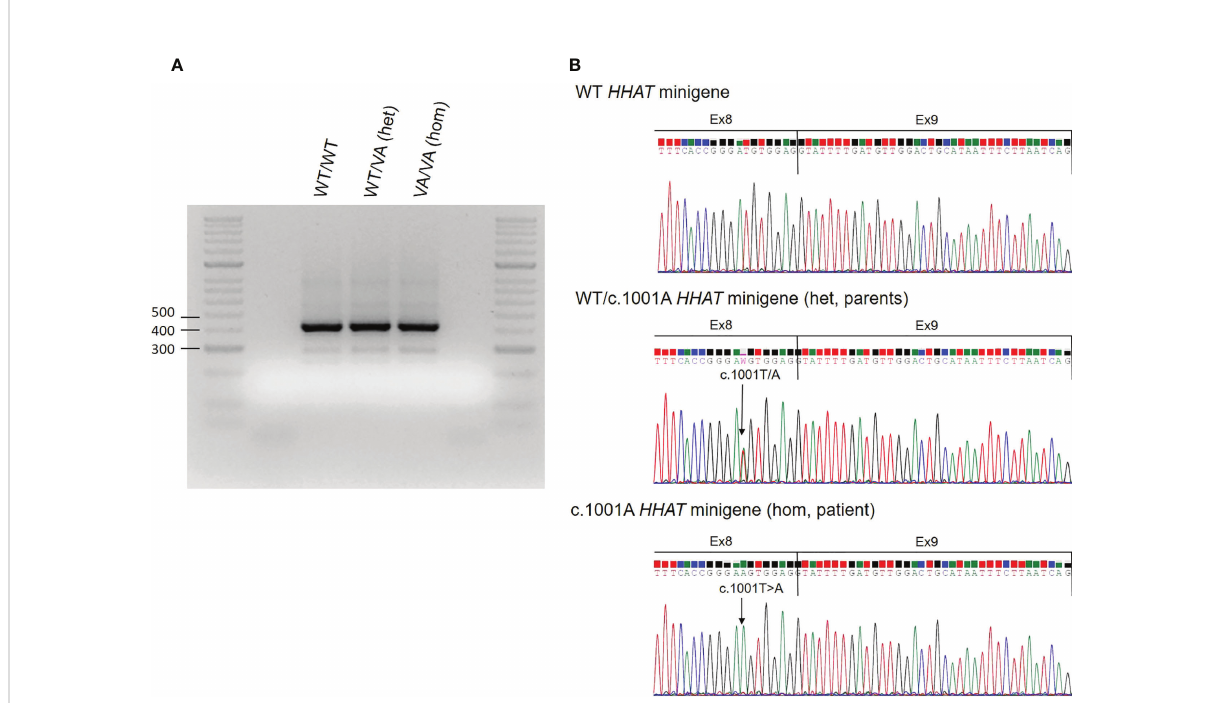
FIGURE 3 Results of the HHAT in vitro minigene functional studies. (A) Results of the HHAT in vitro minigene experiments. COS-7 cells were transfected with wild-type (WT) HHAT, c.1001A mutant HHAT (MT), or both WT/VA HHAT. RNA was extracted, and RT-PCR for HHAT cDNA was performed. The fi gure shows the PCR products on an agarose gel. (B) Electropherograms of the minigene PCR products. The arrow indicates the position of the nucleotide variant c.1001A. Hom, homozygous state; Het, heterozygous